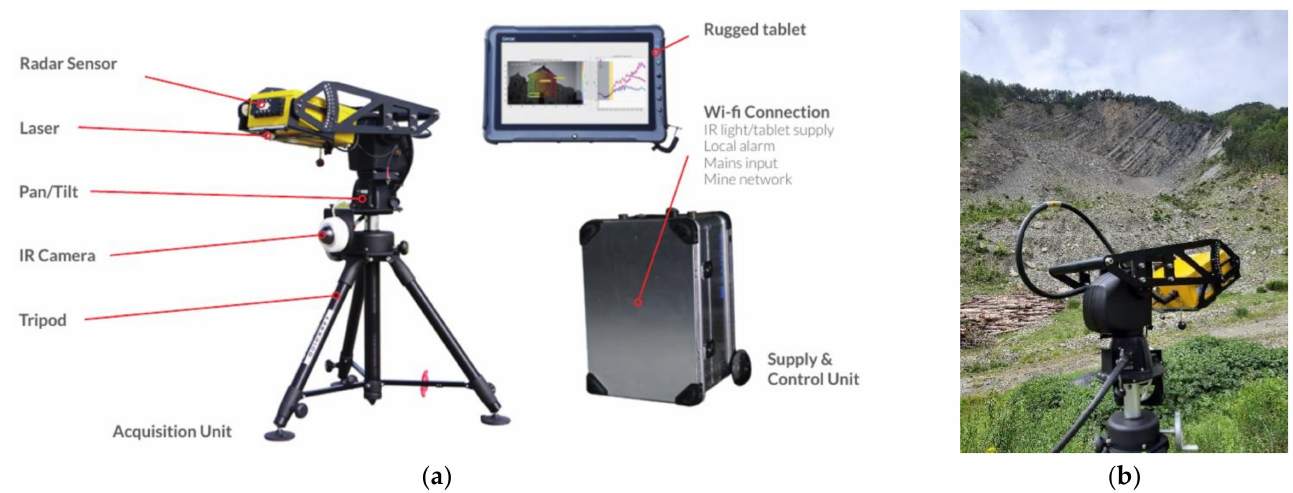
Figure 3. ( a ) HYDRA-G equipment; ( b ) Terrestrial ArcsSAR Interferometry installed at